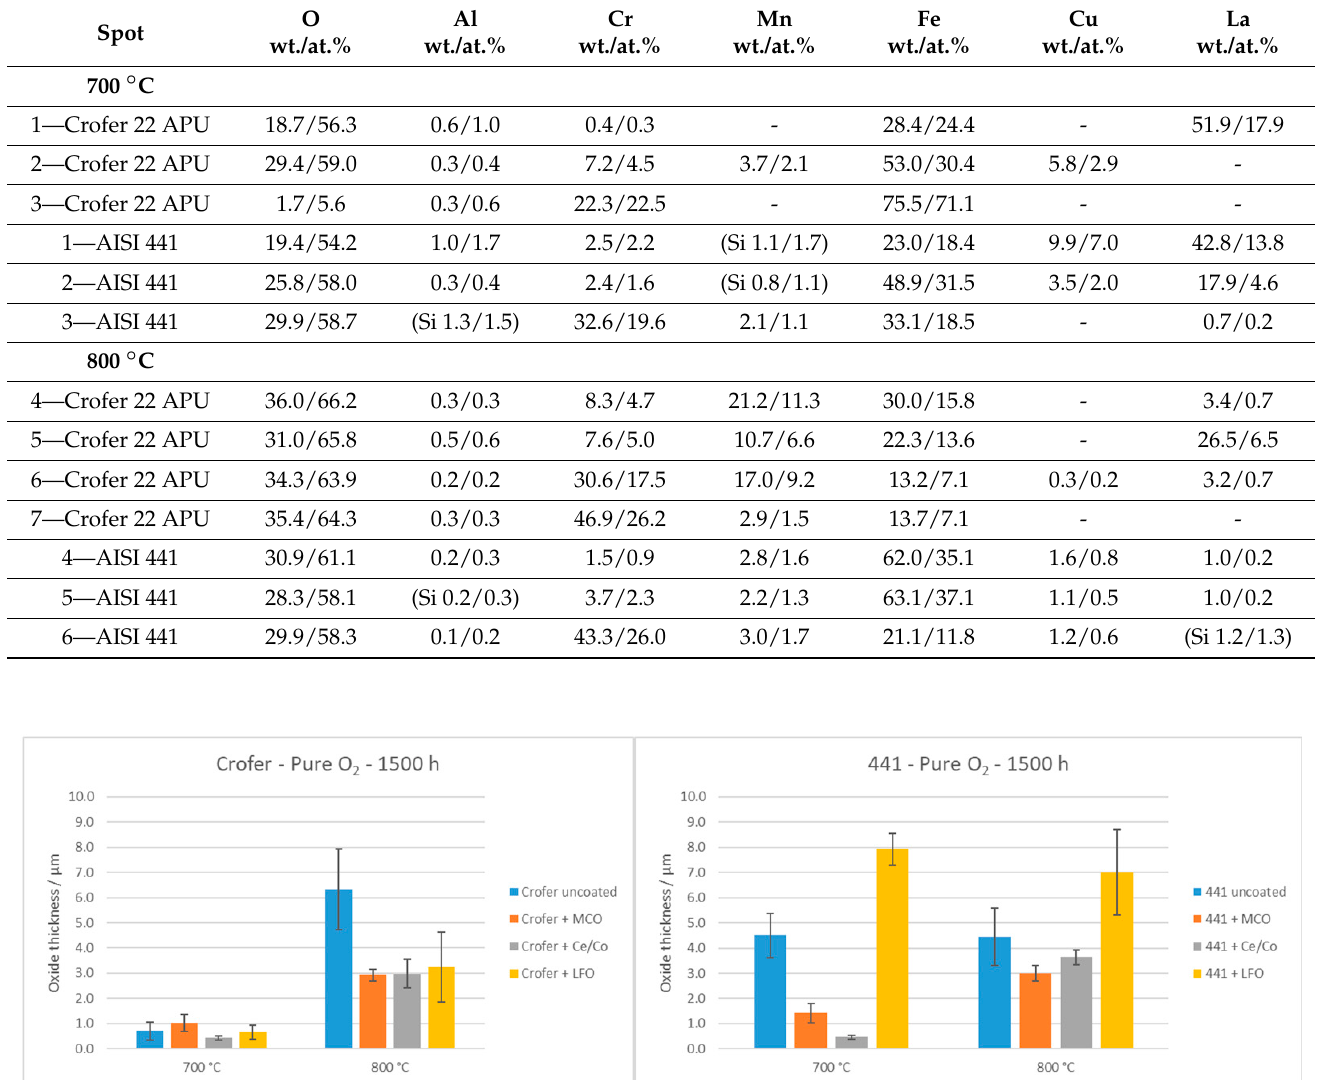
Figure 12. Uncoated Crofer 22 APU ( left ) and Y-coated Crofer 22 APU ( right ) after 1500 h at 700 and 800 °C in reducing atmosphere. The red line indicates the position of the EDS linescan profiles shown in Figure 13.